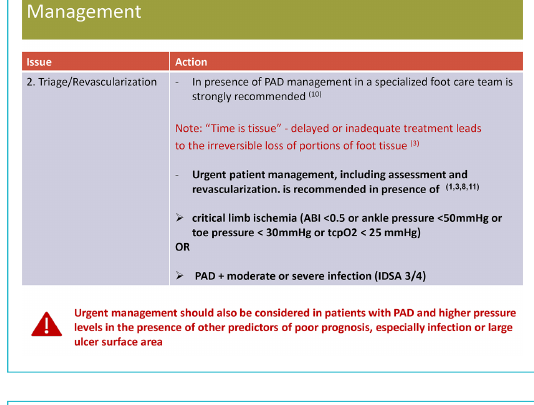
Figure 2: Example of the guidance for awareness in suspected acute Charcot